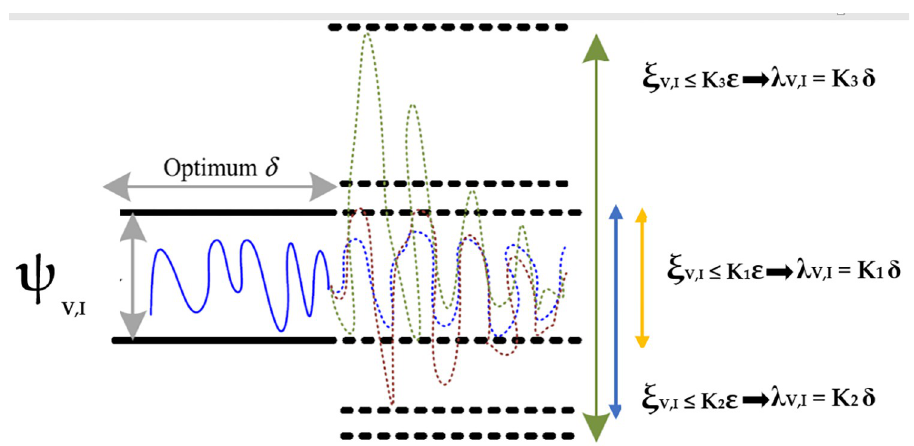
Fig 11. Tuning of weighing factors with respect to tracking